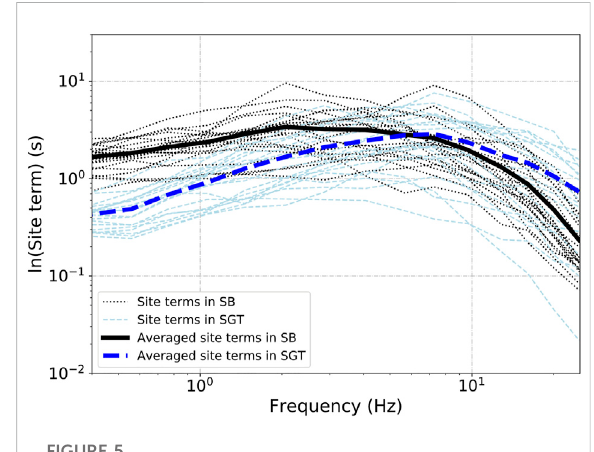
FIGURE 5 Site responses of individual stations in the Sichuan Basin (thinner dotted lines) and Songpan-Ganze terrane (thinner dashed lines) as functions of frequency. The average site response curves of stations in the Sichuan Basin and those in the Songpan- Ganze terrane are plotted as thick solid line and thick dashed line